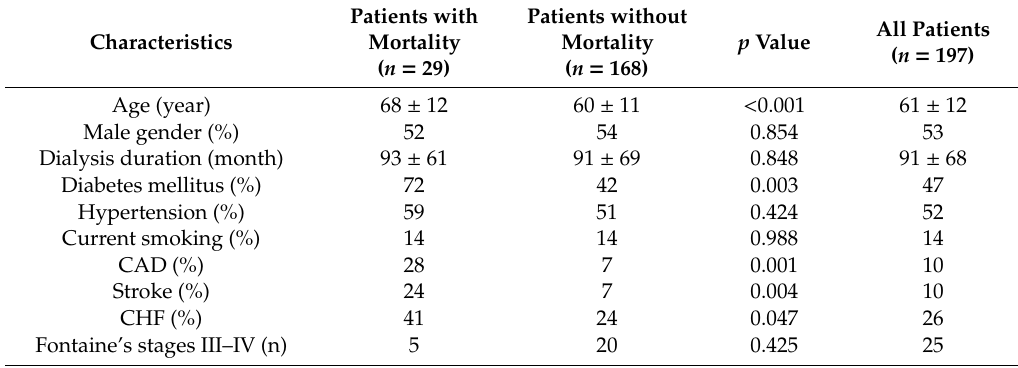
Table 1. Comparison of baseline characteristics between patients with and without